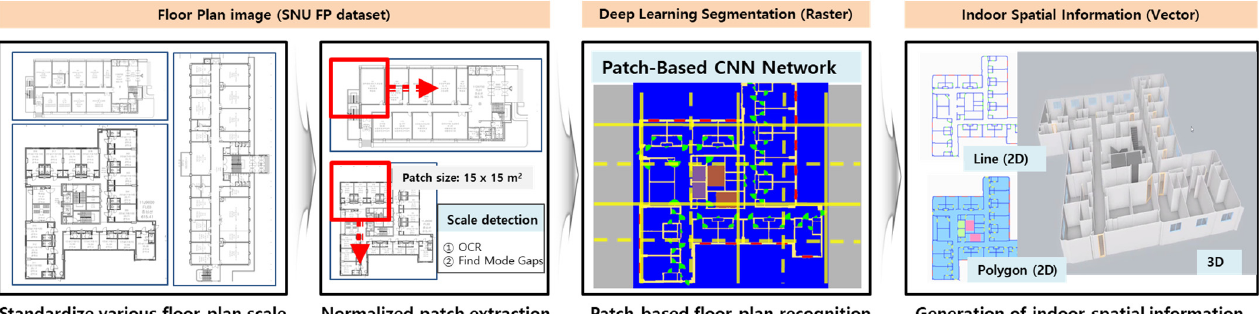
Figure 2. Analytical framework.